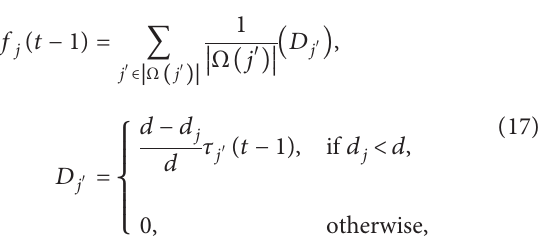
Figure 4: The sketch map of the pheromone diffusion